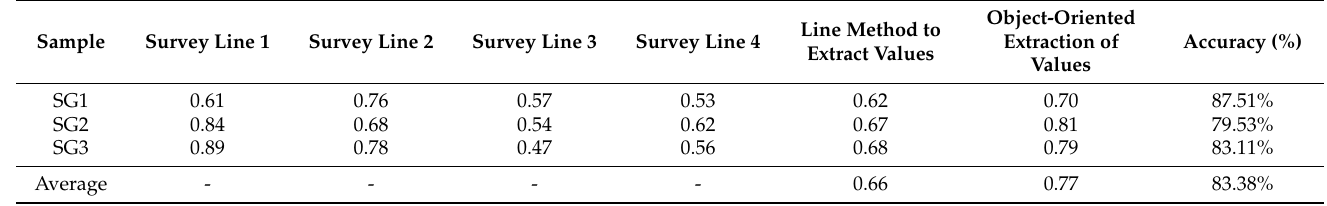
Table 7. An accuracy analysis of object-oriented method to extract sample plot canopy